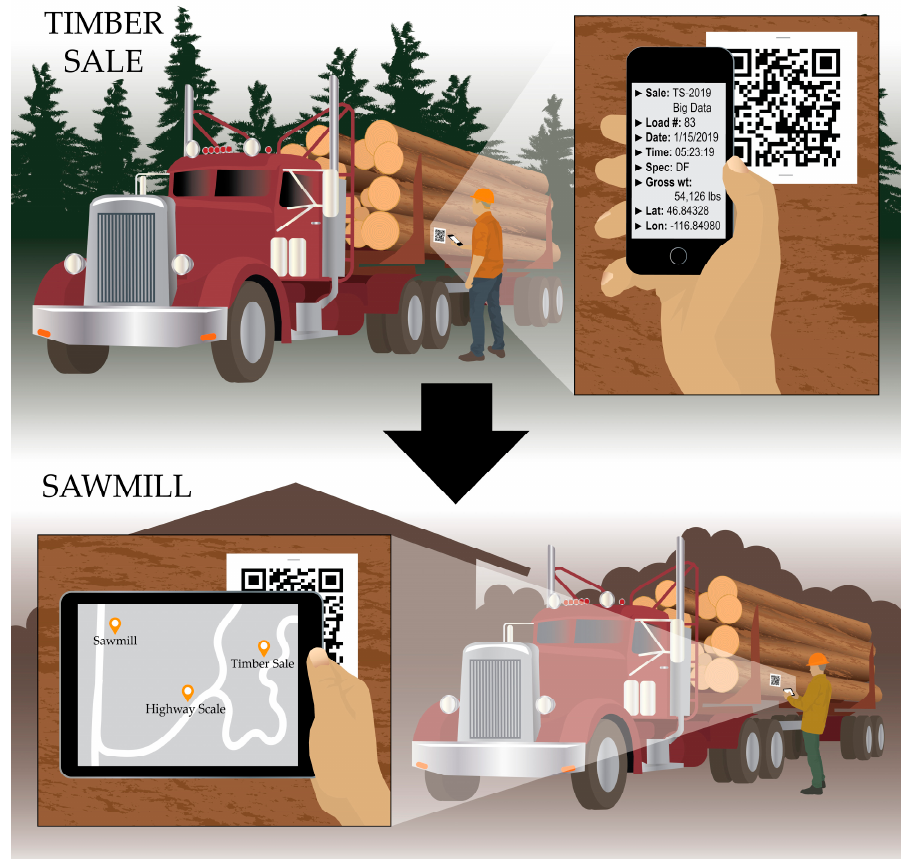
Figure 9. Quick response (QR) codes printed at the jobsite with log load information are scanned again at multiple waypoints, such as truck weight scales on a state highway and the sawmill. Chain of custody information, like the weight of the load, can be monitored, and, insofar as the time and place of the truck is recorded on a map multiple times, this method serves as a form of positioning.